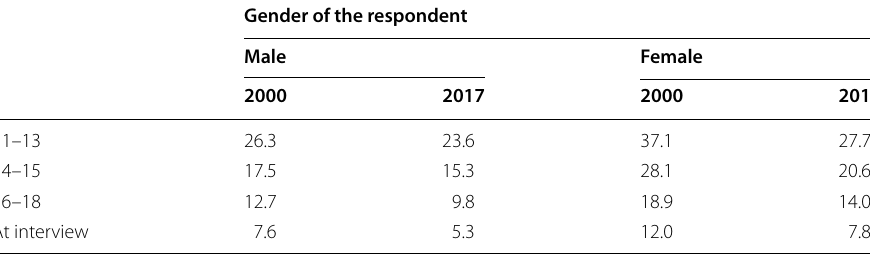
Source: authors’ elaboration on SIS and SELFY surveys